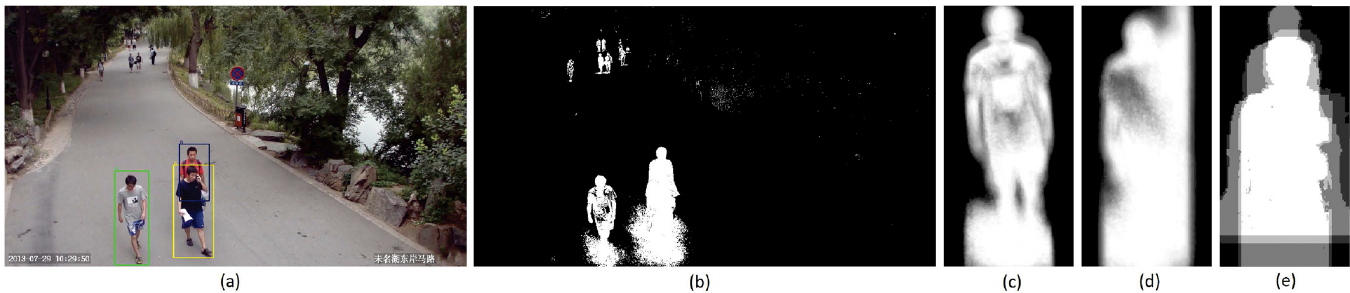
Fig 4. An example of gait silhouettes extracted from a real free-view scene: (a) A sample frame from the Camera WMHD in the PKU HumanID dataset, where three pedestrians are labeled using color bounding boxes (green for subject 0, yellow for subject 6 and blue for subject 8); (b), (c) and (d) The extracted gait silhouettes for the three